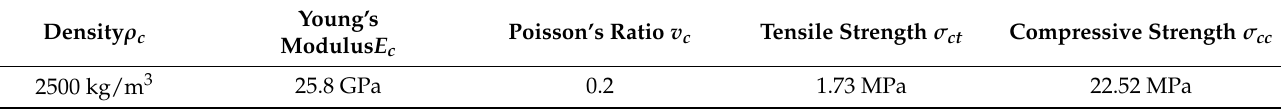
Table 3. Properties of cast-in-situ concrete